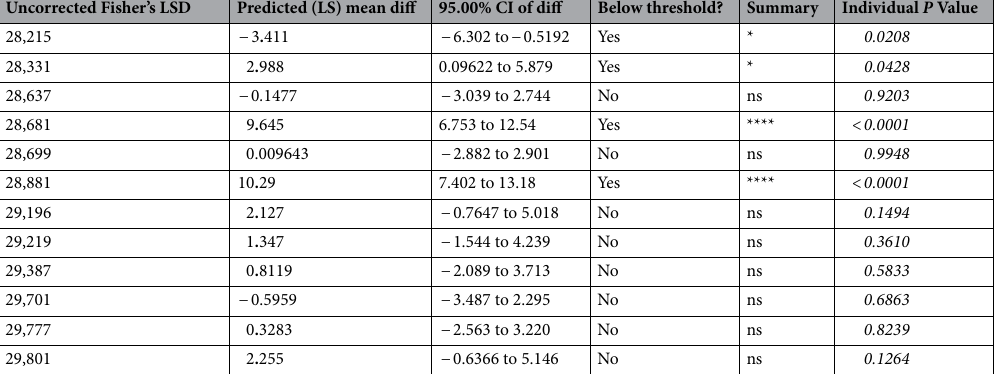
Table 2. Uncorrected Fisher’s LSD test comparing differences between persistent and non-persistent (on way) in positions showing a median of variability higher than 25%. Spike domain in bold character. CI: confidence interval; LSD: least significant difference; Diff.: differences. Significant values are in bold and italics.